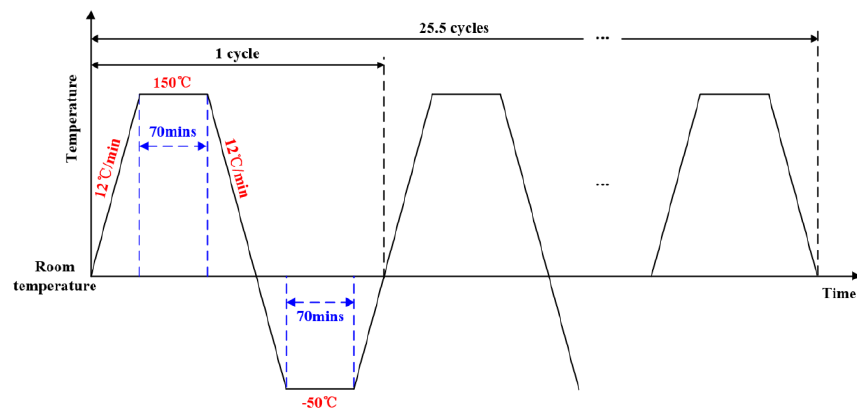
Figure 5. Implementation process of temperature variation.